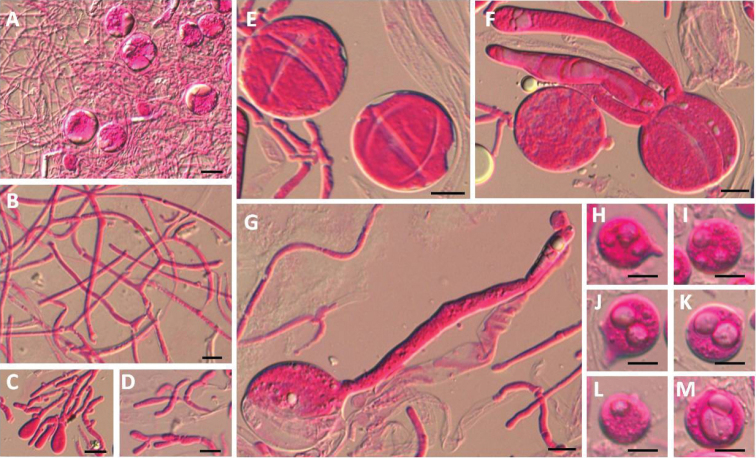
Microscopic structure of Tremellasalmonea (HMAS 279588). A Section through hymenium B Hyphae from context C Swollen cells D Conidia in cluster E–G Mature basidia H–M Basidiospres. Scale bars: 10 μm (A–M).